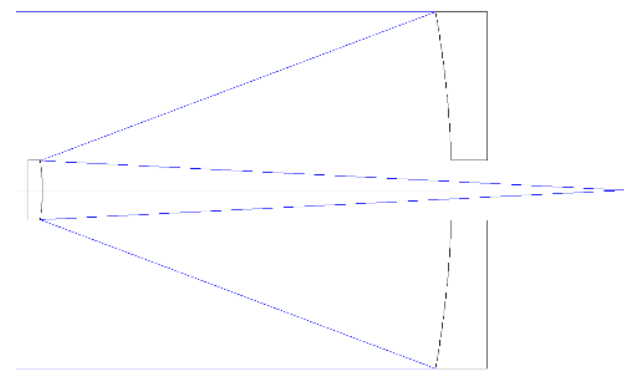
Figure 7. Optical path of the telescope. Table 5. Secondary mirror misalignment